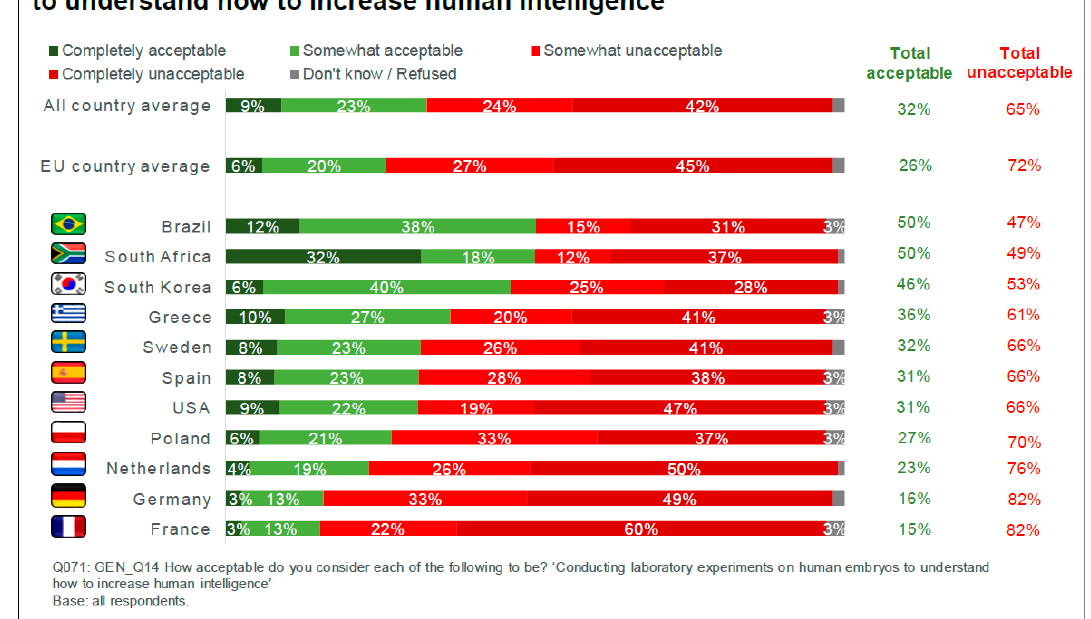
Scheme 3. “Acceptability of conducting laboratory experiments on human embryos to understand how to increase human intelligence” [23] (p. 44).